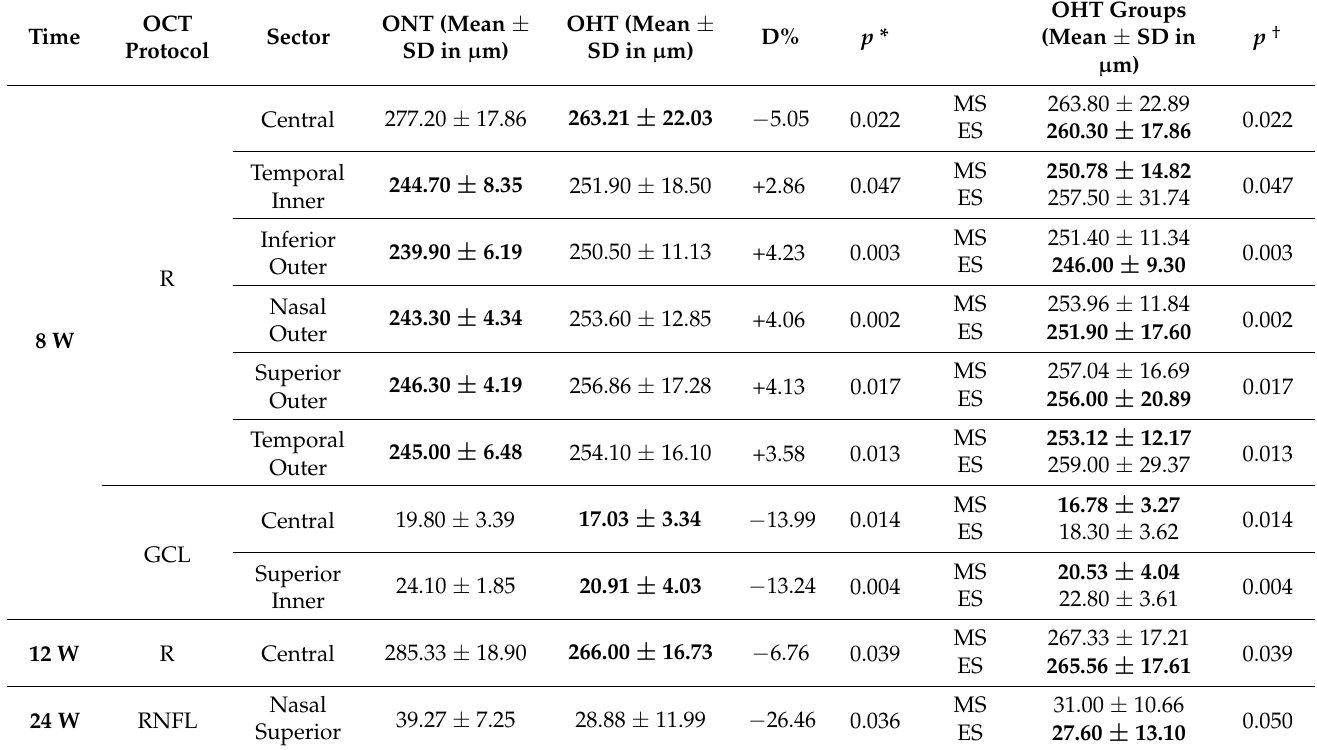
Table 1. Statistically significant differences found by optical coherence tomography parameters analyzed at weeks 8, 12 and